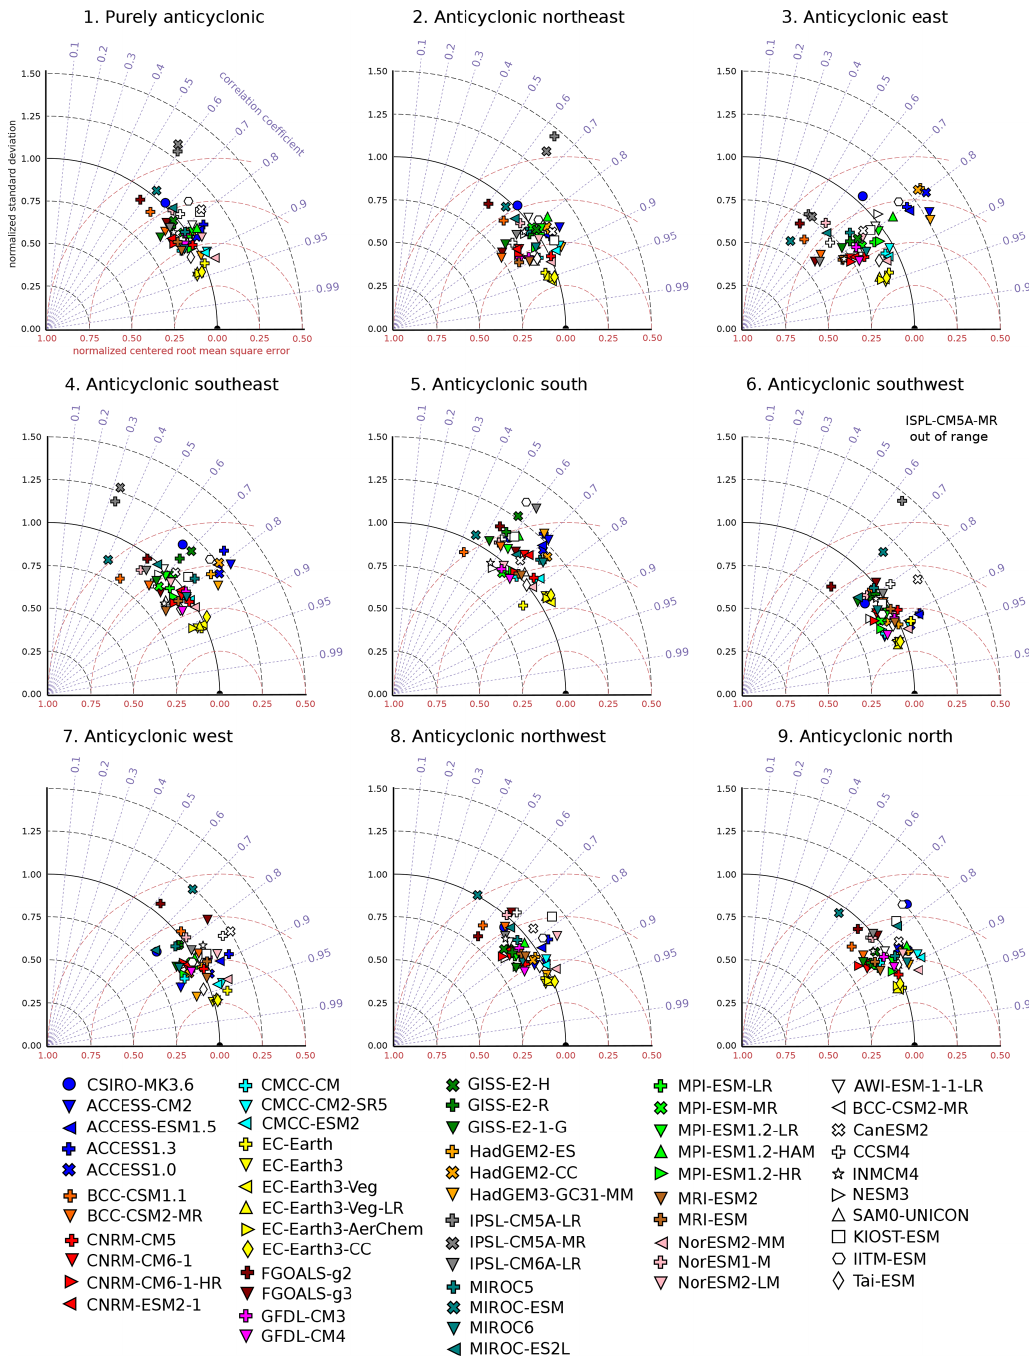
Figure 14. Normalized Taylor diagram for the simulated vs. quasi-observed (from ERA-Interim) relative frequency pattern of a given Lamb weather type between 35 ◦ –70 ◦ N. Each panel corresponds to a specific LWT, and each of the 56 considered models can be identified by a specific marker and colour, as indicated in the legend. Models pertaining to the same coordinating institution have the same colour. Shown are the results for the nine anticyclonic Lamb weather